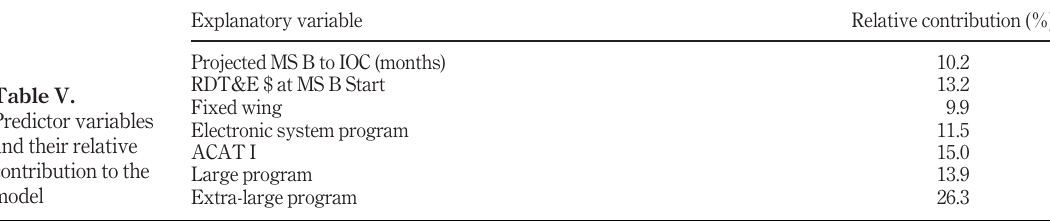
Table V. Predictor variables and their relative contribution to the